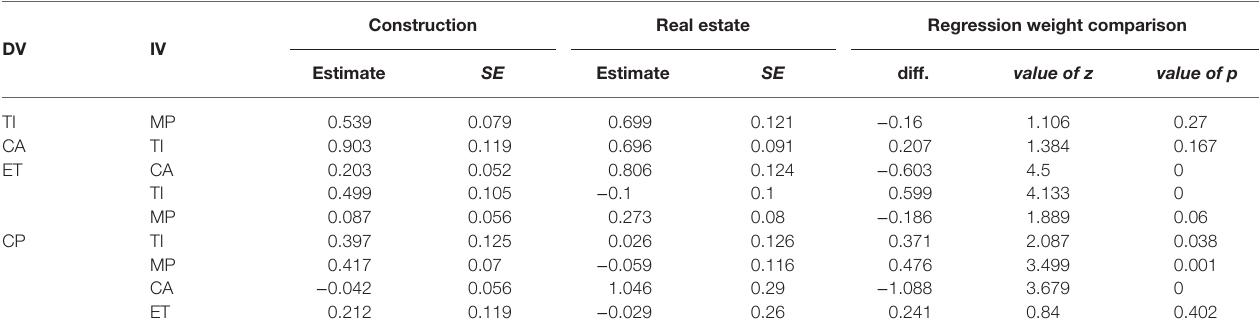
TABLE 6 | Multiple-group comparison regression